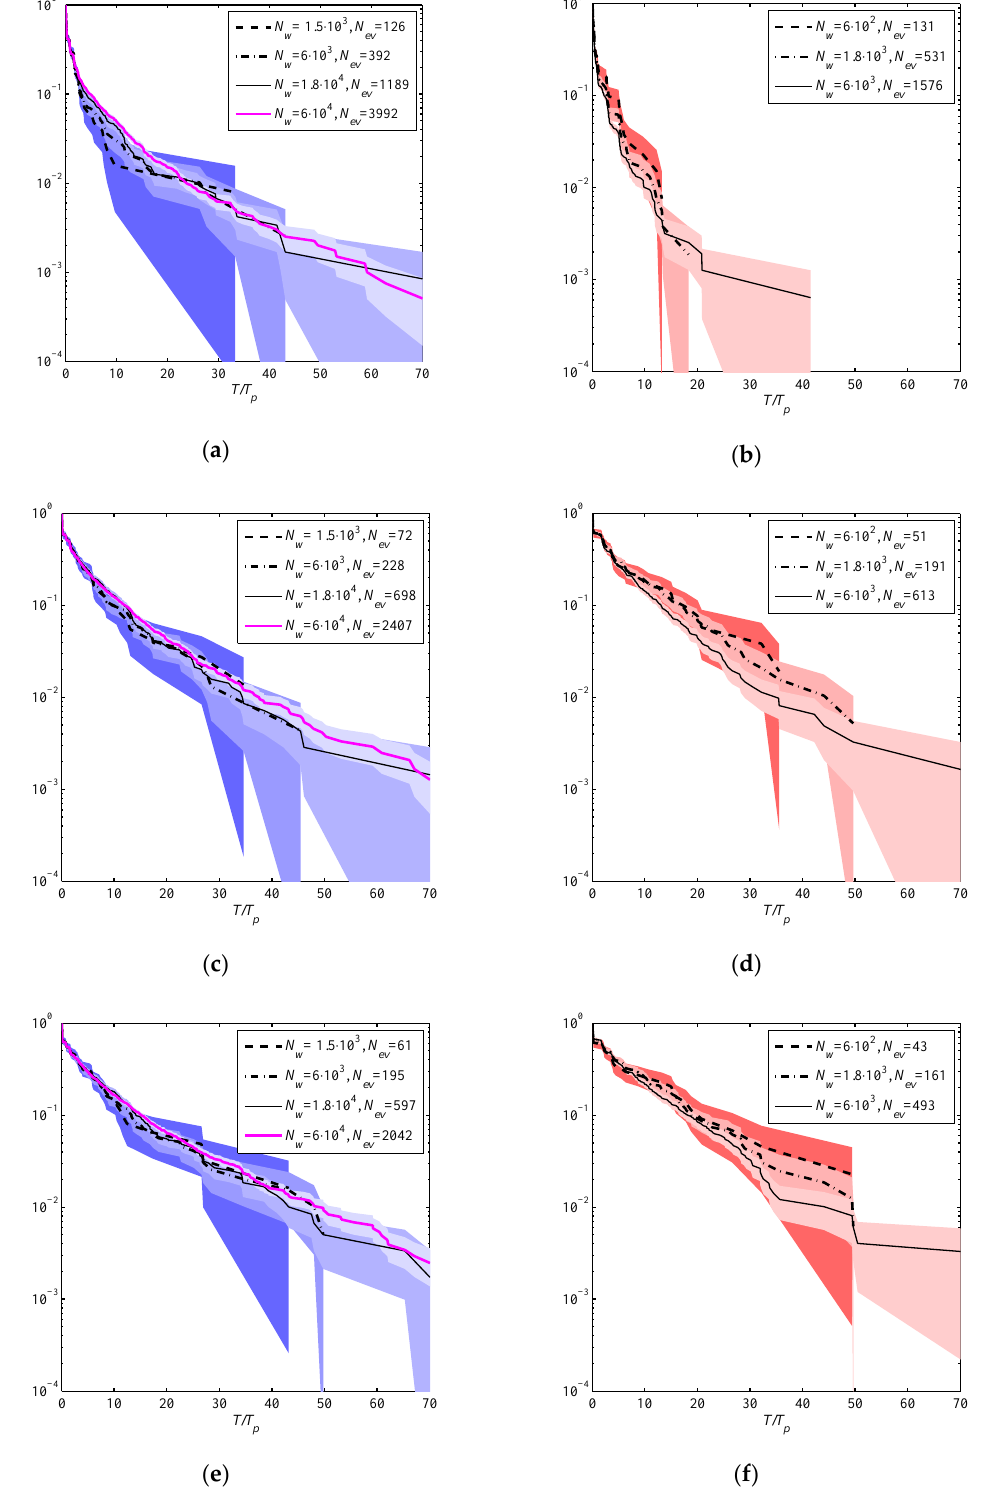
Figure 2. Exceedance probability distributions for rogue event lifetimes P (lines) and the corresponding confidence intervals P ± Δ P (filled areas, from deep to light colors, correspond to small to large statistical ensembles) for different databases. The legends give the number of the simulated for 1200 s waves, N w , and the total number of found rogue wave events, N ev . ( a ) series A 0 , m = 1; ( b ) series E 0 , m = 1; ( c ) series A 0 , m = 2.5; ( d ) series E 0 , m = 2.5; ( e ) series A 0 , m = 4; ( f ) series E 0 , m = 4.